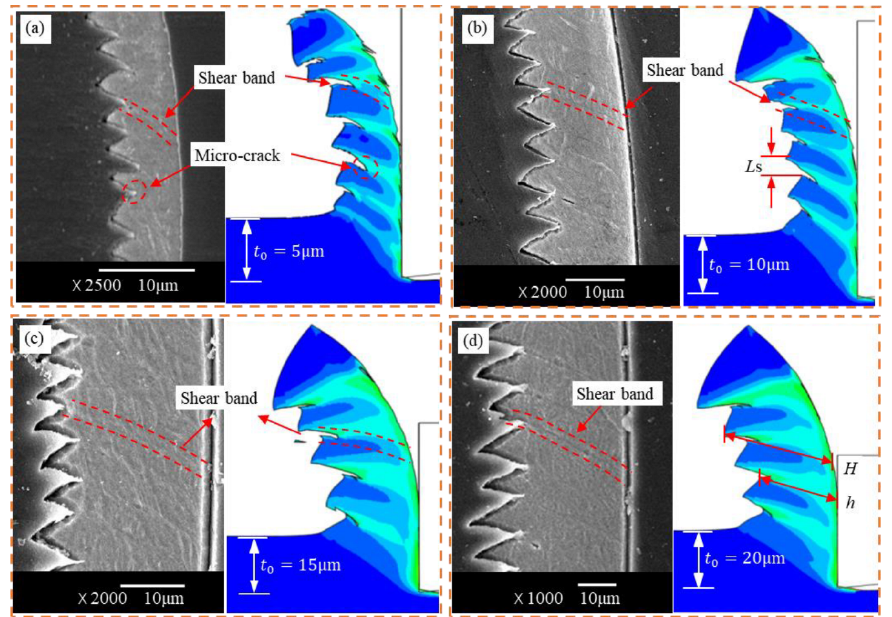
Figure 11. Comparative results of the simulated and experimental serrated chips for a cutting speed of 60 mm/min; ( a ) t 0 = 5 µ m, ( b ) t 0 = 10 µ m, ( c ) t 0 = 15 µ m, ( d ) t 0 = 20 µ